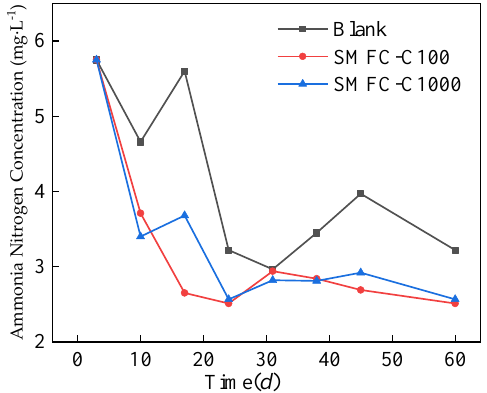
Figure 4. COD concentration curves.